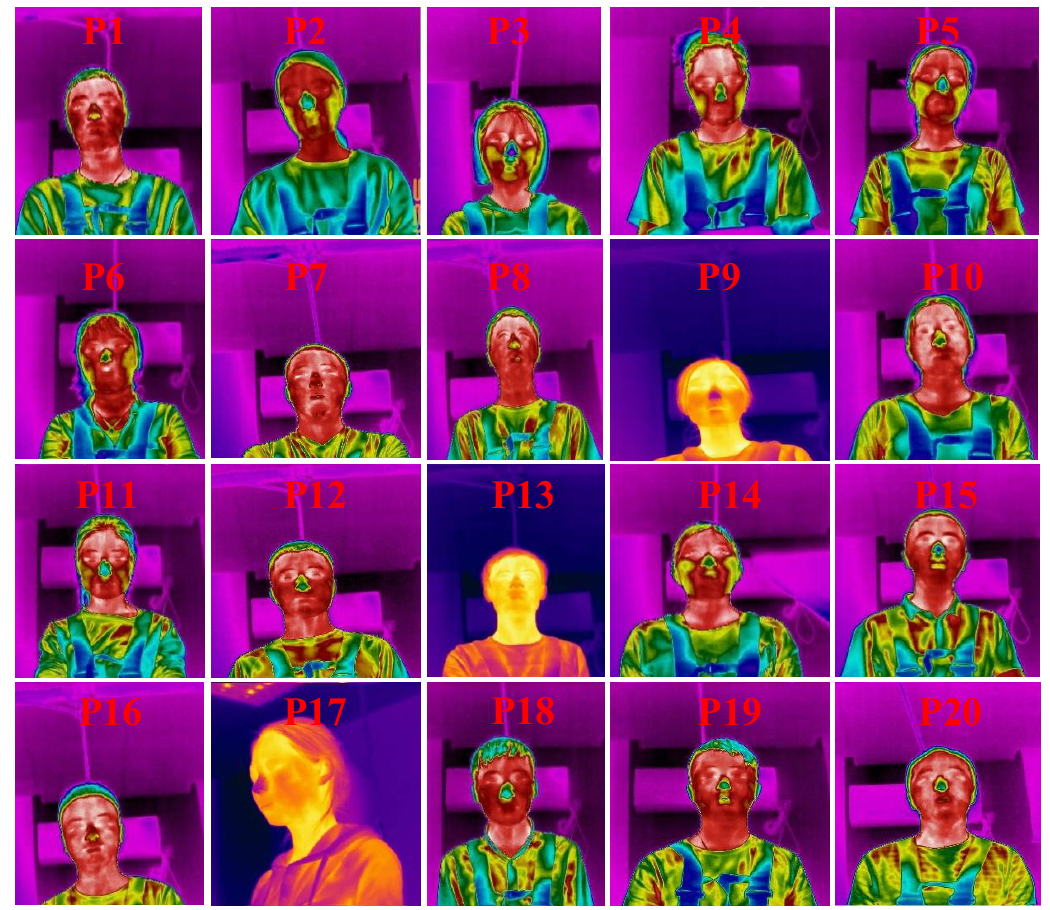
Figure 3. Examples in CISS-Infrared video datasets.